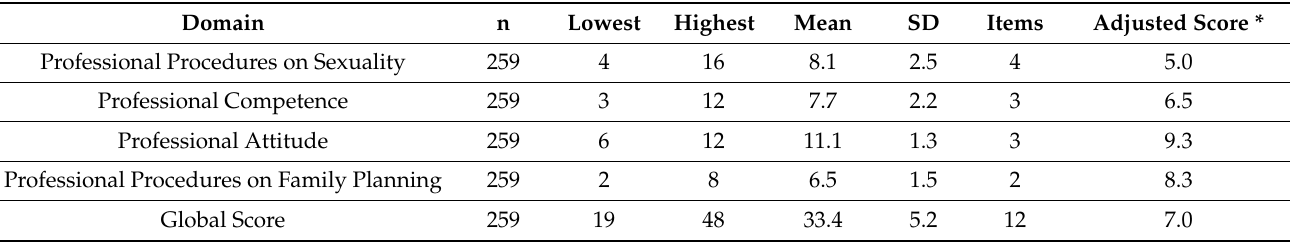
Table 9. Scores of the Domains and Global